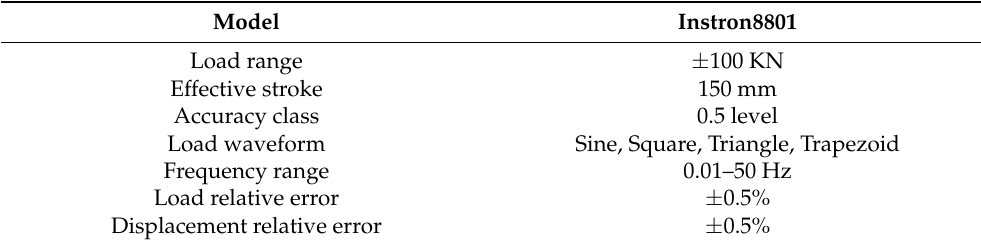
Table 3. Parameters of the Instron 8801 fatigue testing machine.